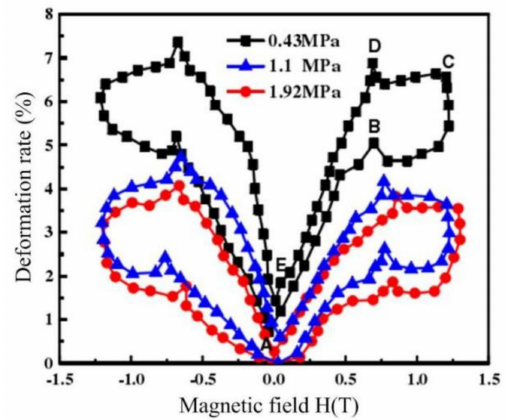
Figure 13. Hysteresis